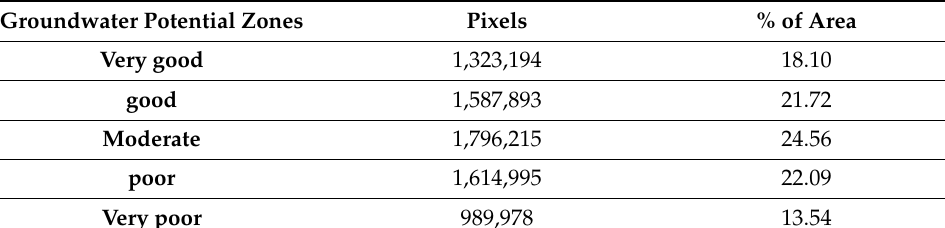
Table 5. Percentage area estimated in various categories of GWP zones in ensemble model.